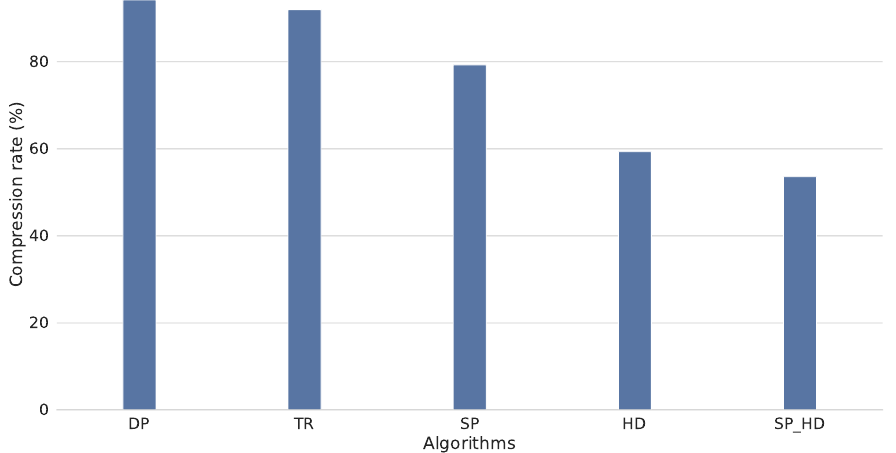
Figure 20. Compression ratio achieved by different algorithms.